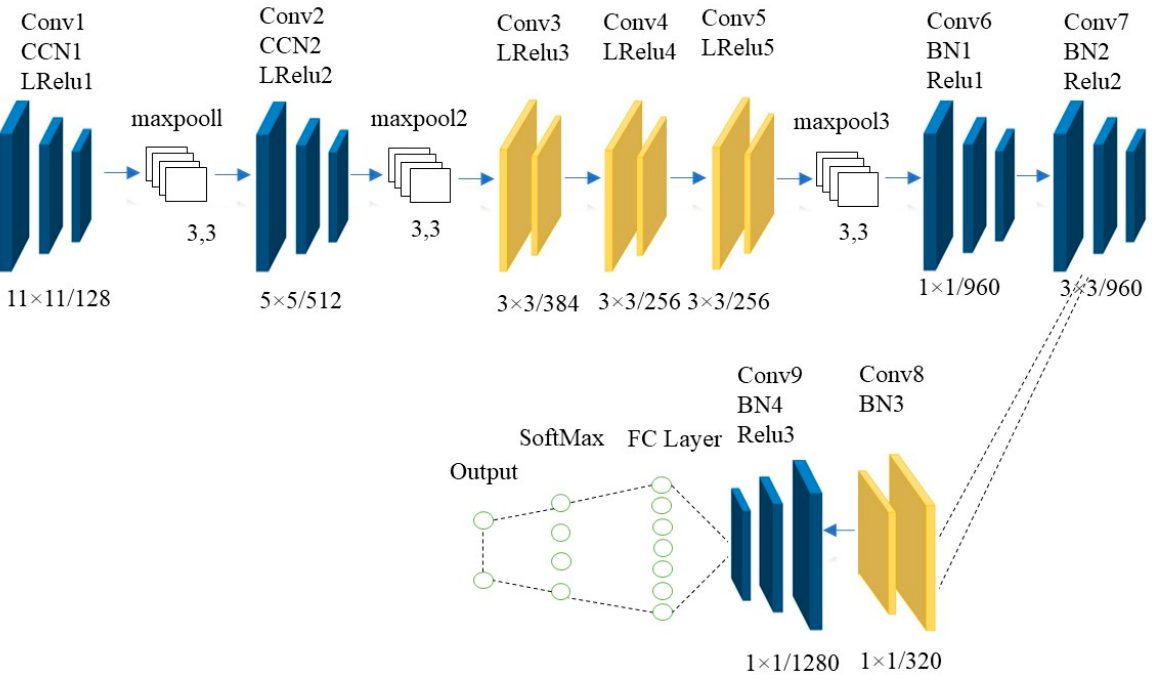
Figure 2. The architecture of the proposed CovidDetNet